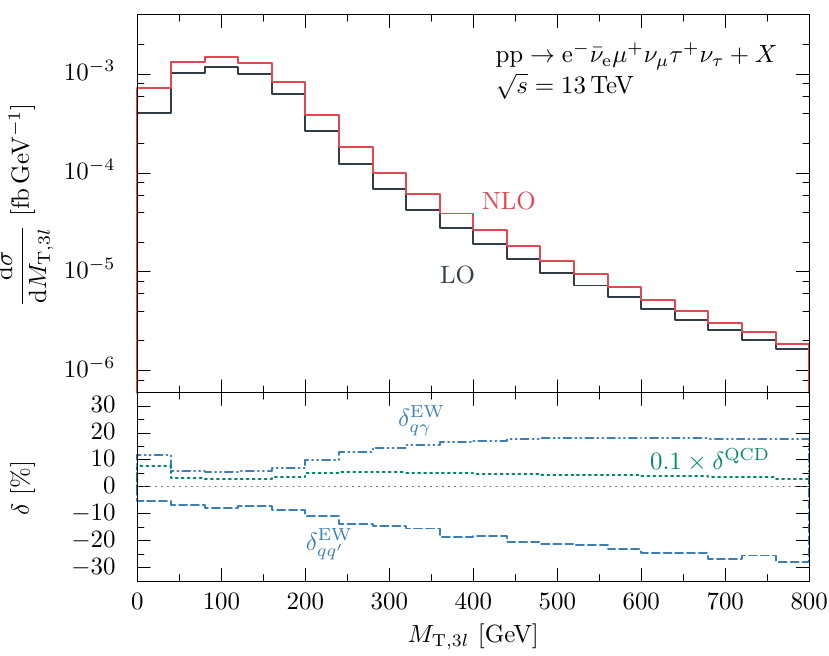
Figure 7. Di(cid:11)erential distribution in the transverse mass M T ; 3 ‘ of the three-lepton system. The NLO QCD correction (cid:14) QCD is scaled down by a factor of 10 for better readability.